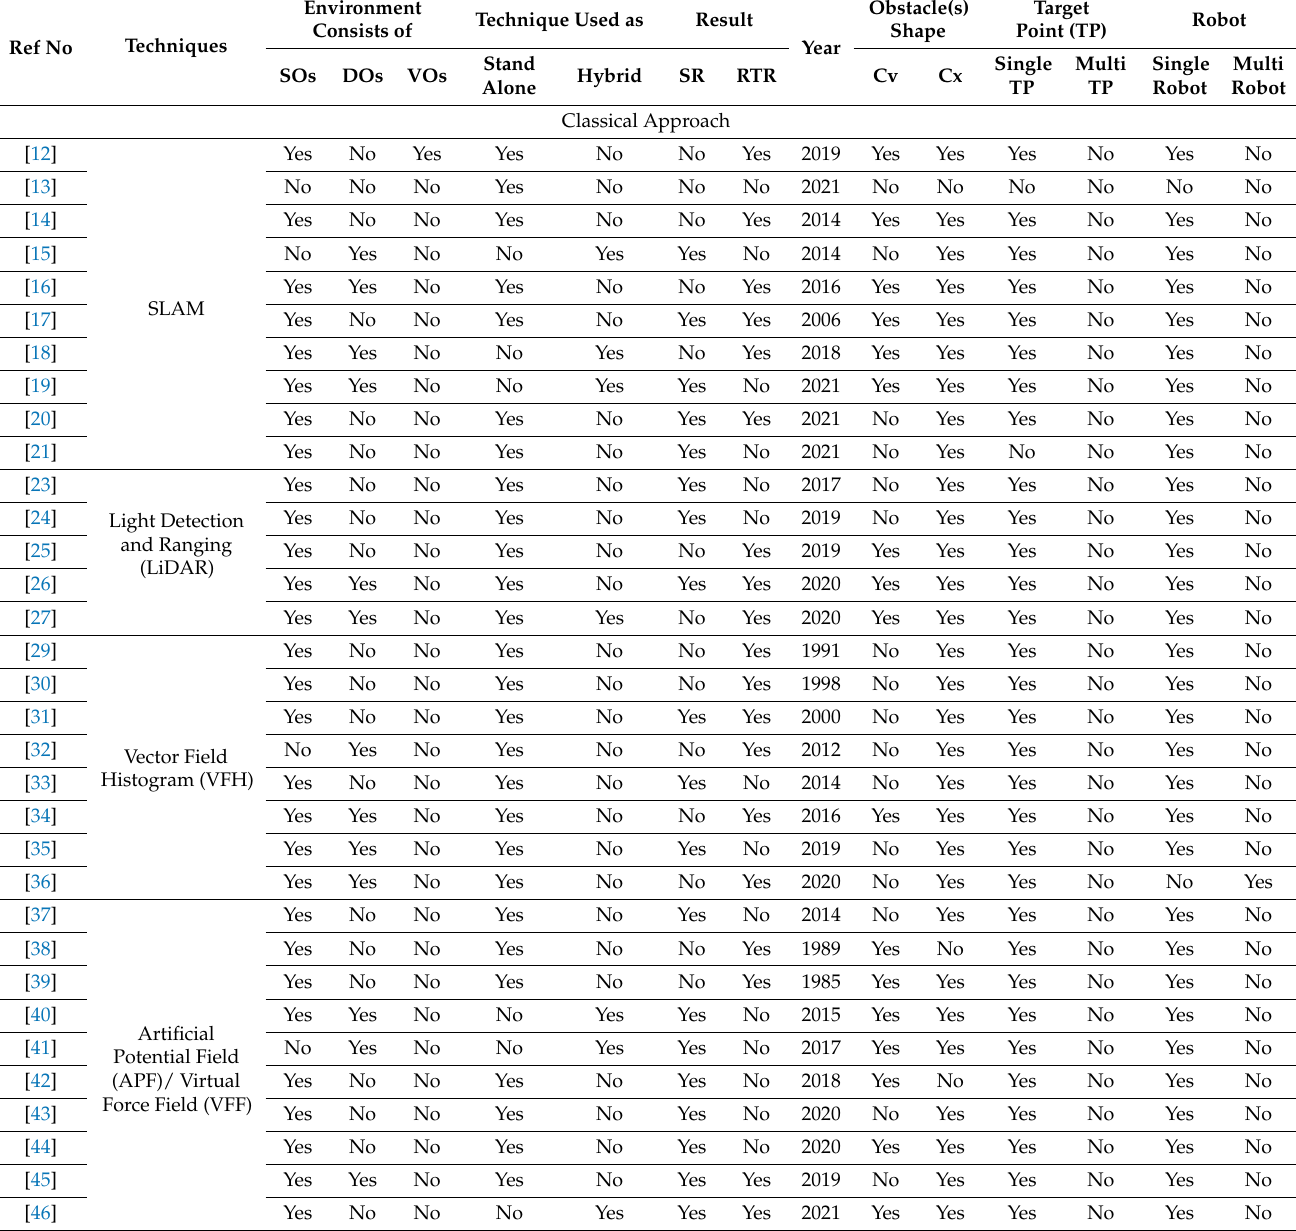
Table 1. Analysis of various path planning and navigation algorithms amidst